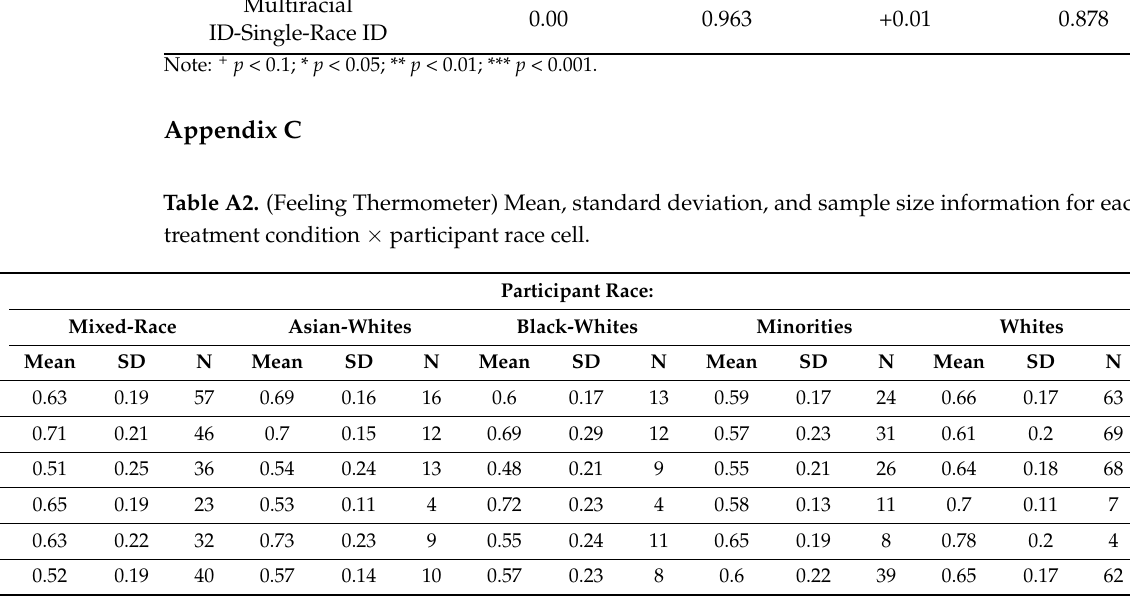
Table A1. Results from difference-of-means t -tests comparing support for biracial-identified candi- dates among biracial-identified mixed-race heritage participants and single-race-identified mixed-race heritage participants. Includes only mixed-race participants (those indicating mixed-race heritage by parentage) and only those who evaluated biracial-identified candidates. Results show that both those who we identified as mixed-race by heritage and those who actively identified as “Multiracial” have indistinguishable point estimates in terms of their evaluations of biracial-identified candidates. Mixed-Race Participants Difference of Groups Feeling Thermometer Vote Intention Difference of Means p-Value Difference of Means p-Value Multiracial 0.00 0.963 +0.01 ID-Single-Race ID